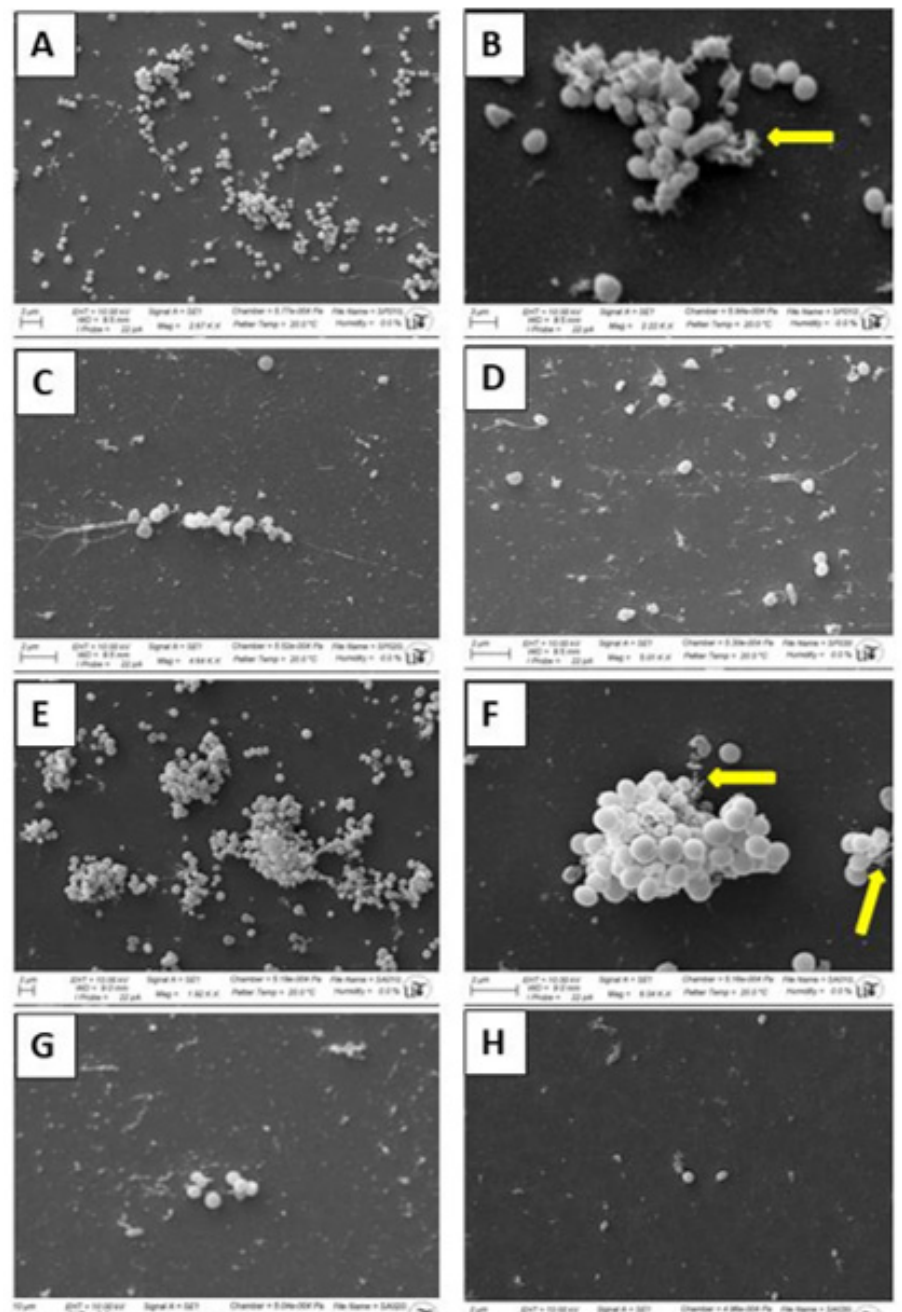
Figure 5. Observations by SEM of biofilms formed by staphylococcal species after 24 h on glass slides and the effect of DHAB on biofilm formation. ( A ) Biofilm formed by S. pseudintermedius in the absence of DHAB; ( B ) closer view of colonies of S. pseudintermedius in the absence of DHAB. Yellow arrows point out extracellular material (particulated material and fibers) secreted by bacteria for attachment; ( C ) small colonies of S. pseudintermedius in the presence of DHAB at MIC; ( D ) individual cells of S. pseudintermedius in the presence of DHAB at MBC. Note the presence of small and deformed cells; ( E ) biofilm formed by S. aureus in the absence of DHAB; ( F ) colonies of S. aureus in the absence of DHAB. Yellow arrows show extracellular material (particulated material and fibers) secreted by bacteria for attachment; ( G ) small colonies of S. aureus in the presence of DHAB at MIC; and ( H ) individual cells of S. pseudintermedius in the presence of DHAB at MBC. Note the presence of small and deformed cells at a high DHAB concentration.